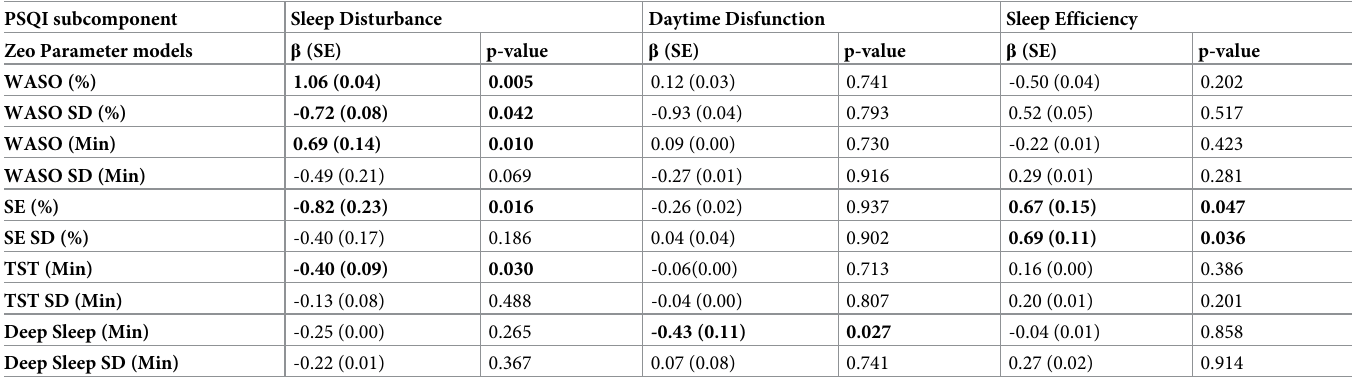
Table 2. Linear mixed effects models of PSQI components and Zeo parameters. PSQI